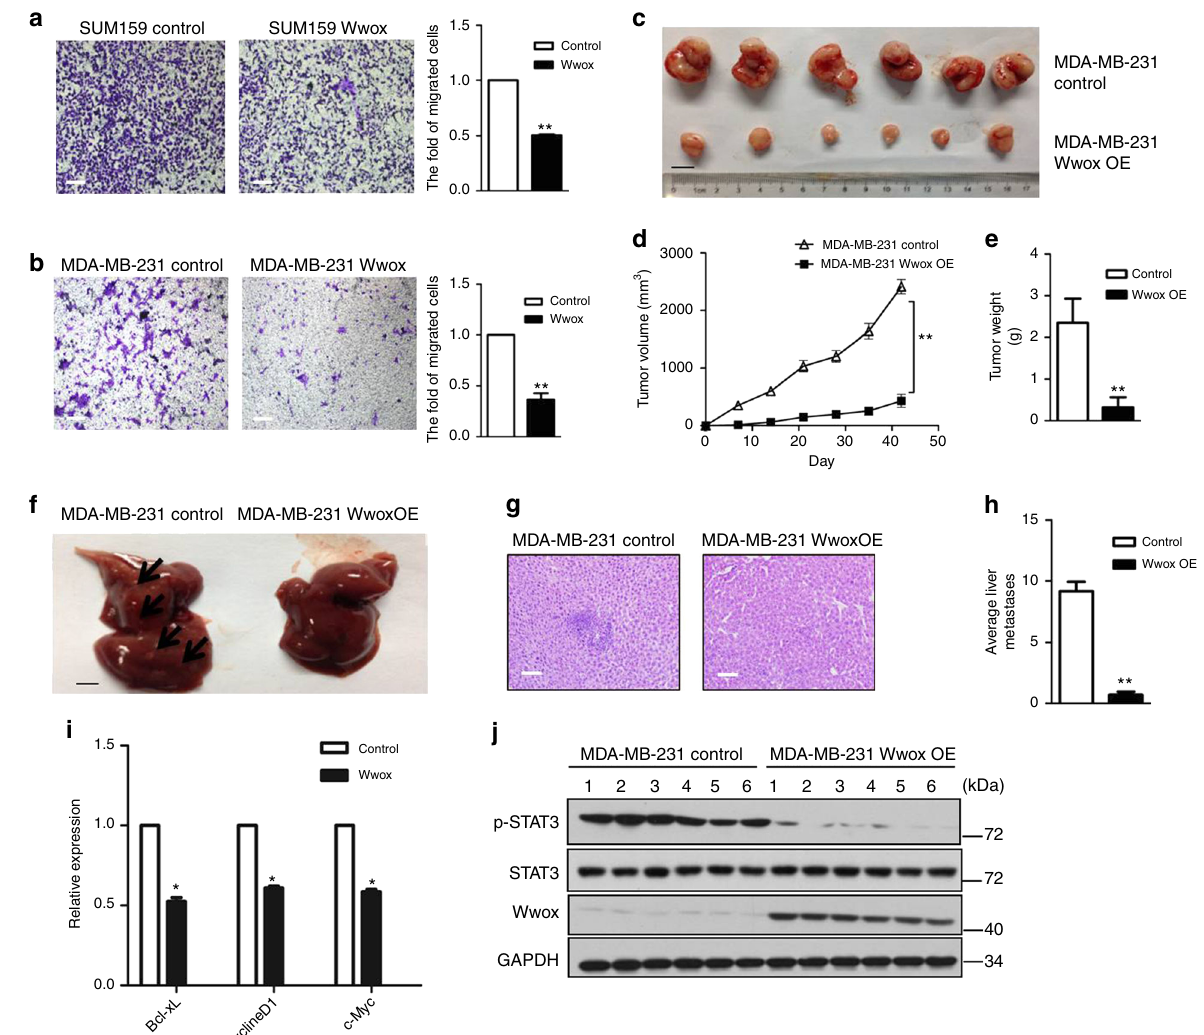
Fig. 2 Wwox inhibits metastasis and tumor proliferation. a , b Transwell migration assays were performed with SUM159 and MDA-MB-231 cells stably transfected with control or Wwox-encoding vectors. Representative images of migrated SUM159 ( a ) and MDA-MB-231 ( b ). Quantitative results are respectively illustrated for migration in a , b . Data represent the mean ± SD ( n = 3) from three independent experiments; ** p < 0.01, Student ’ s t -test. Scale bar, 100 μ m. c – e Wwox inhibits MDA-MB-231 proliferation in vivo. Cells of mock-transfected MDA-MB-231 and Wwox-overexpressing MDA-MB-231 (Wwox OE) lines were orthotopically transplanted into the mice mammary fat pad. Tumor sizes were monitored over a period of 21 days ( d ). At necropsy, tumors were harvested, photographed ( c ), and weighed. Results are presented as mean ± SD ( n = 6) of calculated tumor weight ( e ); ** p < 0.01, Student ’ s t -test. Scale bar, 1 cm. f – h Liver tissues were photographed, fi xed, and stained with hematoxylin and eosin (H&E) ( g ); black arrows indicate the liver metastatic lesions ( f ). The number of metastatic lesions in each specimen was counted ( h ). Results are presented as mean ± SD ( n = 6); ** p < 0.01, Student ’ s t -test. ( f ), Scale bar, 1 cm, ( g ) scale bar: 100 μ m. i Expression of STAT3-targeted genes was examined in indicated MDA-MB-231 cells. Results shown are mean ± SD from three repeats; * p < 0.05. j Western blot analysis of the levels of p-STAT3 in MDA-MB-231 Wwox-overexpressing tumors and control tumors from orthotopic xenograft transplantation